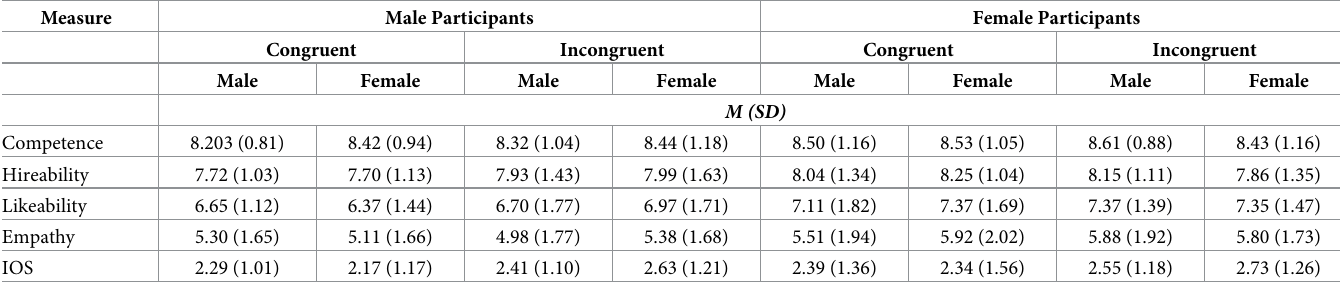
Table 9. Summary of candidate ratings by experimental group in Study